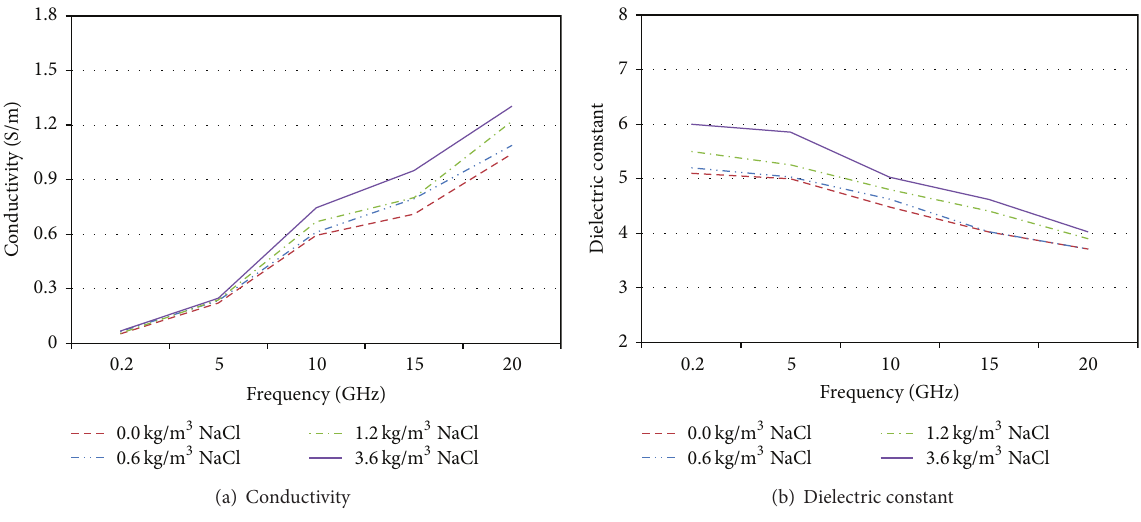
Figure 4: Conductivity and dielectric constant (w/c